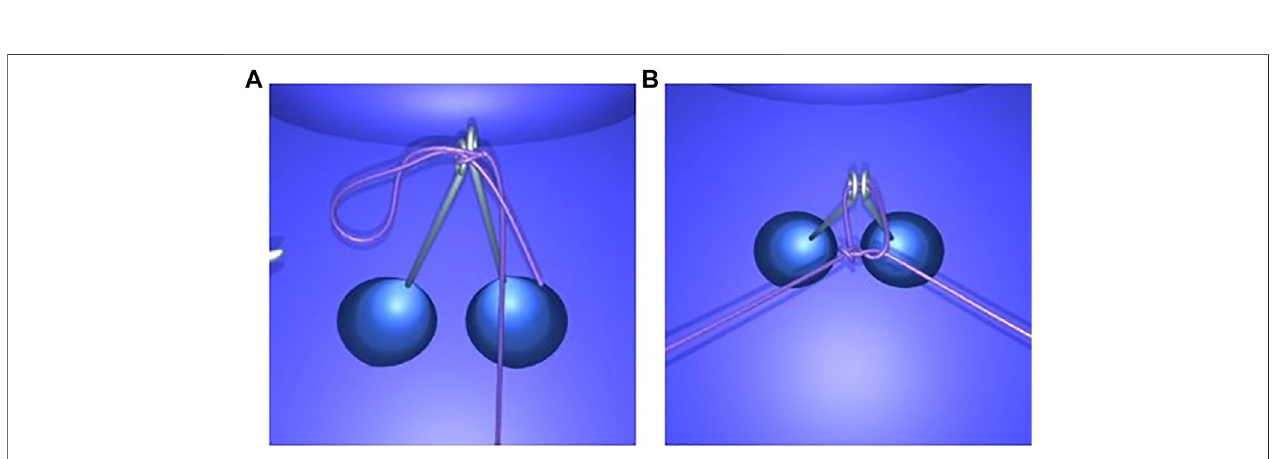
FIGURE10| Firststep ofasurgeon ’ sknot.Thedoubleoverhand knot iscreatedbywrapping thethread around aninstrumenttip (A) ,grasping theotherend,and pulling itthrough the double loop, resulting in apattern with two twists (B) . The knot position can be adjusted byexertingtraction on one end, thus moving the knot over to the other end (C,D) . The collision is suf fi ciently robust to support thread interactions with itself and with the other elements.